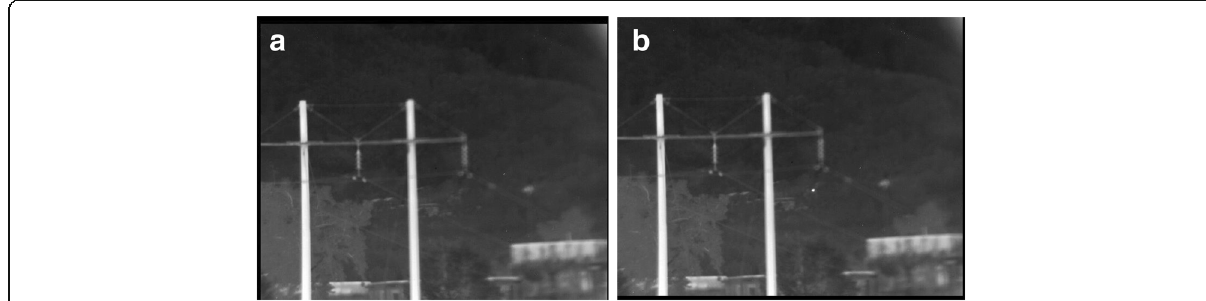
Fig. 17 Effect of a long-range weak target imaging experiment with laser active illumination. a 1 km no cat ’ s eye echo background image and